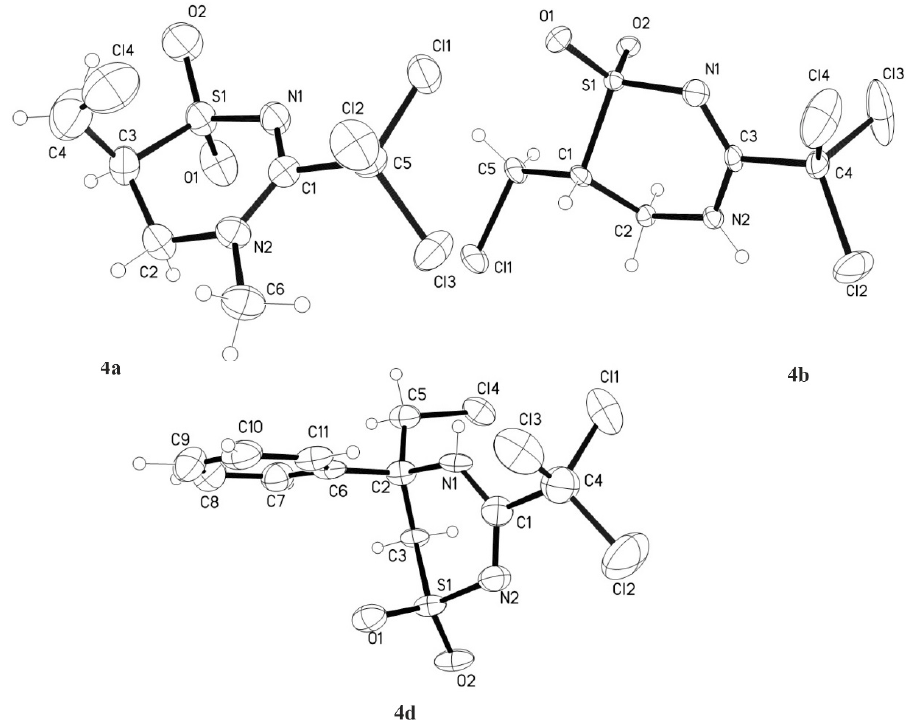
Figure 2. Molecular structure of compounds 4a , b , d including thermal displacement ellipses with 50% probability.